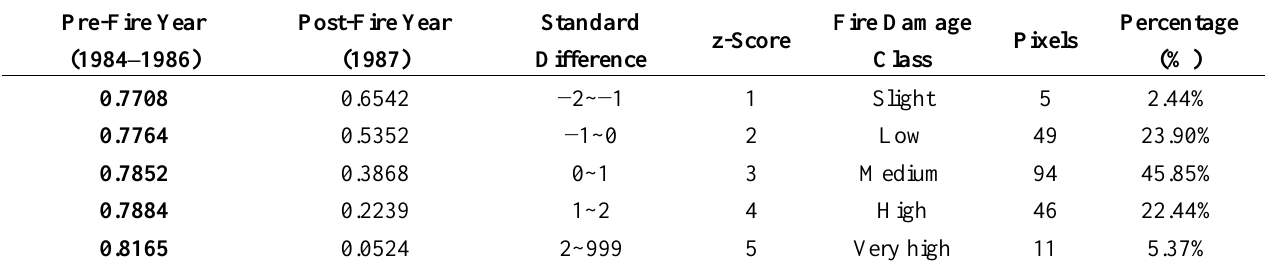
Table 2. Fire damage classification using the z-score method.